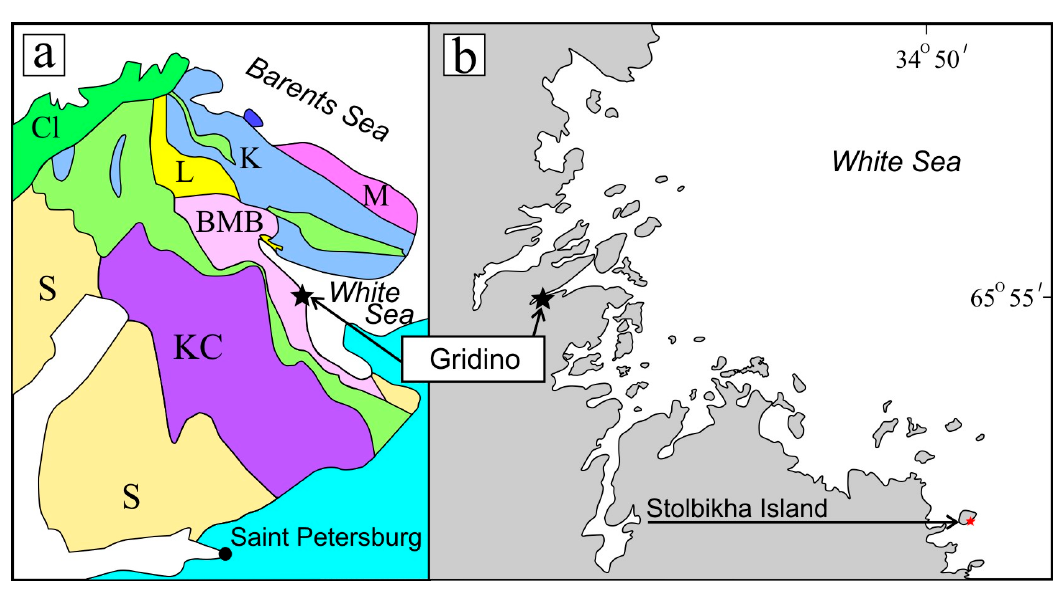
Figure 1. ( a ) Sketch map showing the structure of the Fennoscandian Shield, modified after [ 9 , 24 ]. (M) Murmansk craton, (K) Central Kola domain, (L) Lapland granulite belt, (BMB) Belomorian mobile belt, (KC) Karelia craton, (S) Svecofennides, (Cl) Caledonides. ( b ) Location of the study area in the eastern outskirts of Gridino village. Small red star indicates the position of the pegmatite vein.